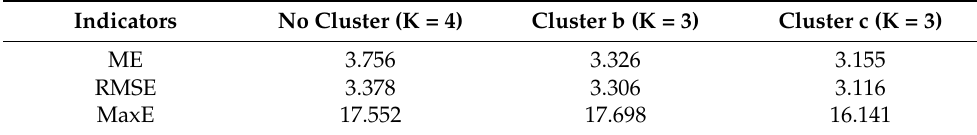
Table 2. Statistics of positioning errors of WKNN based on different clusters and actual identification results